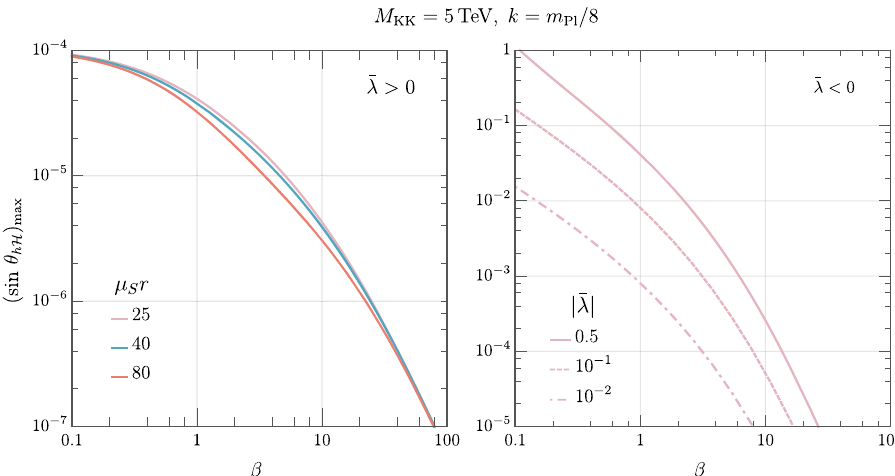
Fig. 3 Maximum allowed value for the parameter sin θ h H , describing the mixing between the lightest Higgs mode with its first KK resonance, as a function of β . In the left figure, we exhibit three different values of ¯ λ = ¯ λ μ > 0, while in S r for max the right panel we consider three different negative values of ¯ λ for a fixed value of μ S r =